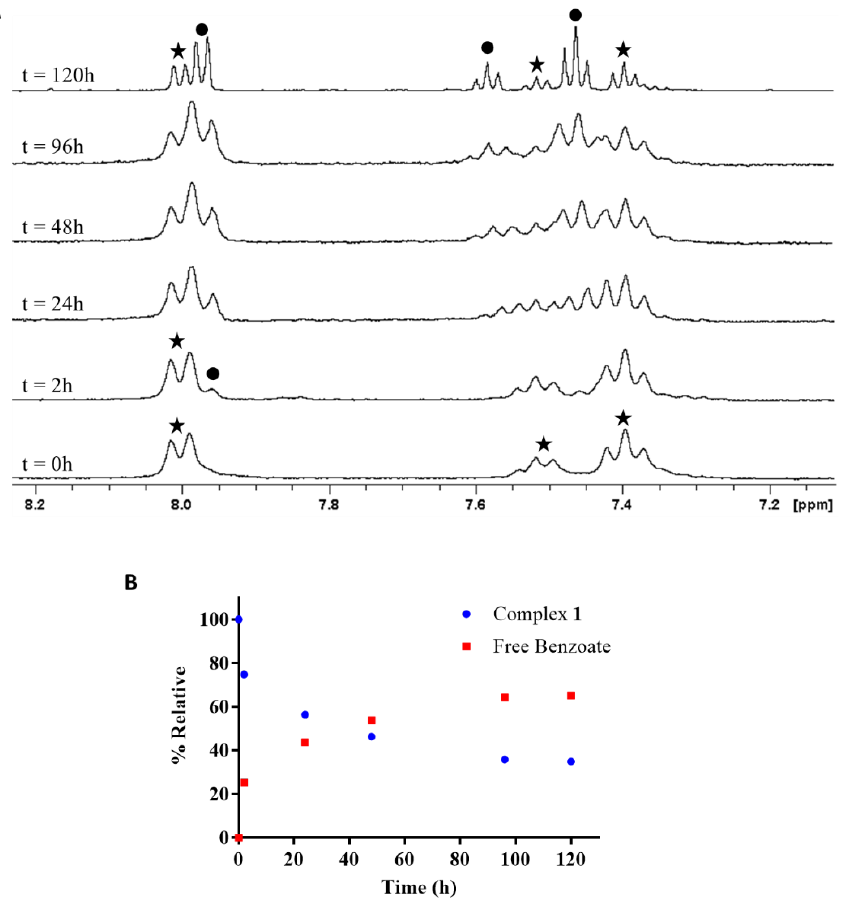
Figure 7. ( A ) Portion of the 1 H-NMR spectra (300 MHz) of complex 1 treated with an excess (1:6 molar ratio) of a 1:1 mixture of ascorbic acid/sodium ascorbate in Acetone-d 6 /D 2 O (550:100, v / v ) at different time intervals at 37 °C. The spectrum at 120 h was recorded on a 500 MHz instrument. The stars indicate the peaks of the benzoato ligands in starting complex 1 , while the black dots indicate the peaks of free benzoate released after reduction of 1 by ascorbic acid. ( B ) Relative percentages of 1 and free benzoate, obtained by integration of 1 H NMR deconvoluted signals (8.20–7.80 ppm), plotted as a function of time.